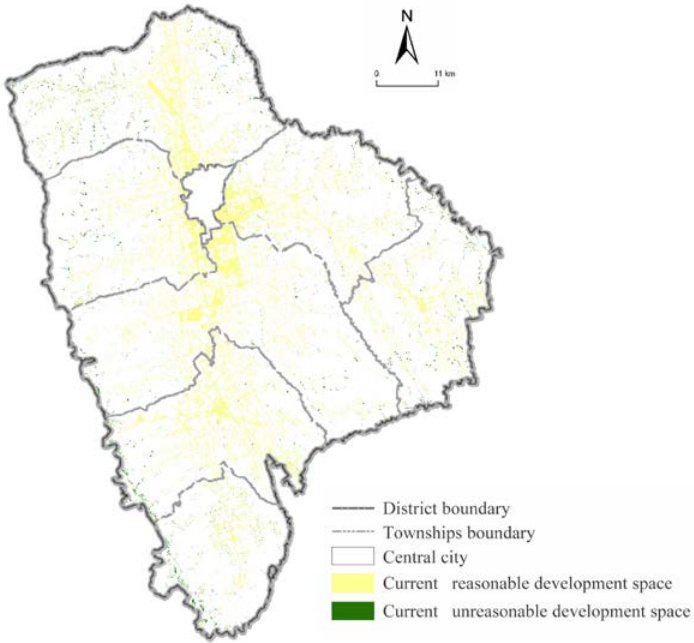
Figure 6. The current development status of construction land in Xifeng.